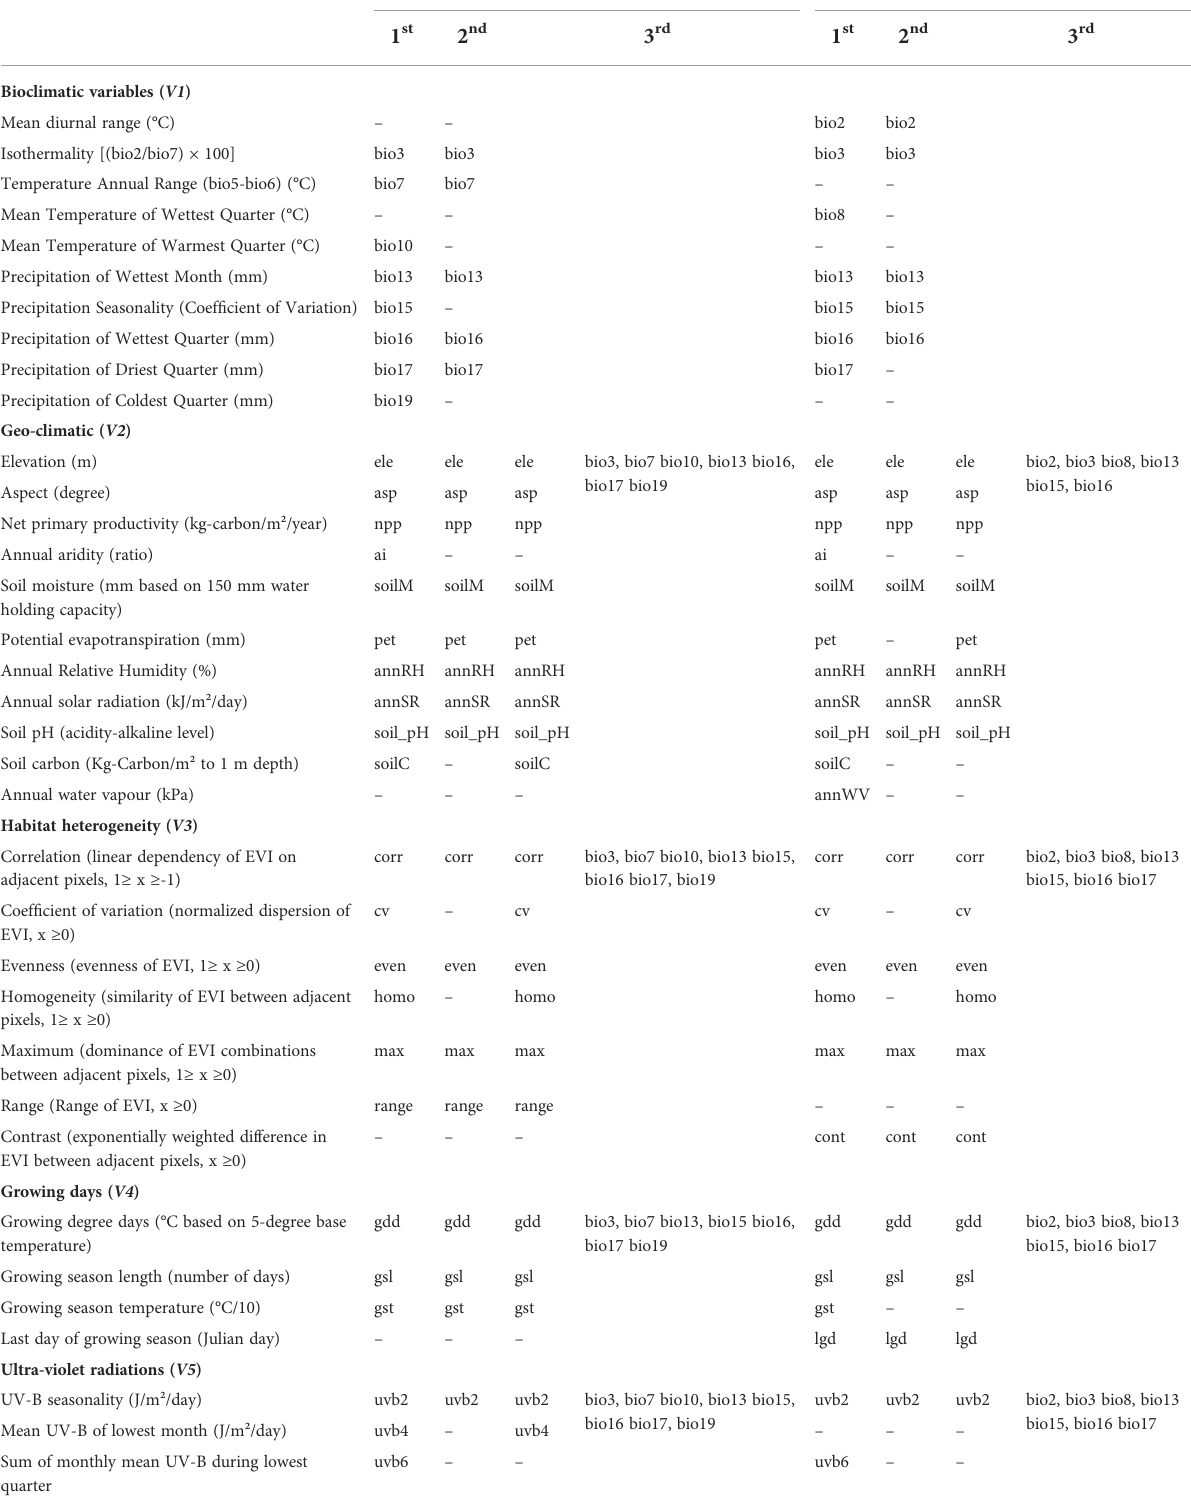
TABLE 1 Multi-step selection of predictive environmental variables for ensemble species distribution modeling (eSDM) of two alpine ‘ glasshouse ’ herbs, Rheum nobile and Rheum alexandrae . Environmental